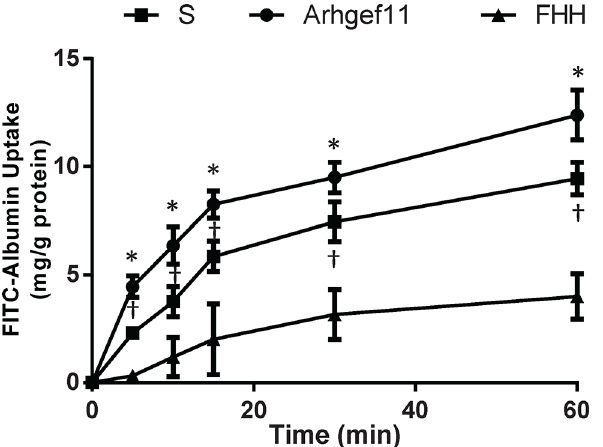
Fig 8. In vitro assessment of albumin uptake in primary proximal tubule cell (PTC). Primary PTC cells (day 5, > 60% confluent) were grown from S and Arhgef11-congenic kidney (at 4 weeks of age) and incubated with FITC-Albumin (10 ug/ml) at 0, 5, 10, 15, 30, 60 min. Primary PTC were derived from fawn-hooded hypertensive (FHH) rat as comparison due to a known genetic defect that impairs tubular re-uptake of albumin/protein (i.e., low albumin uptake). PTCs from S kidney exhibited decreased uptake of FITC-albumin compared to PTC from Arhgef11-congenic, while FHH demonstrated the least ability uptake